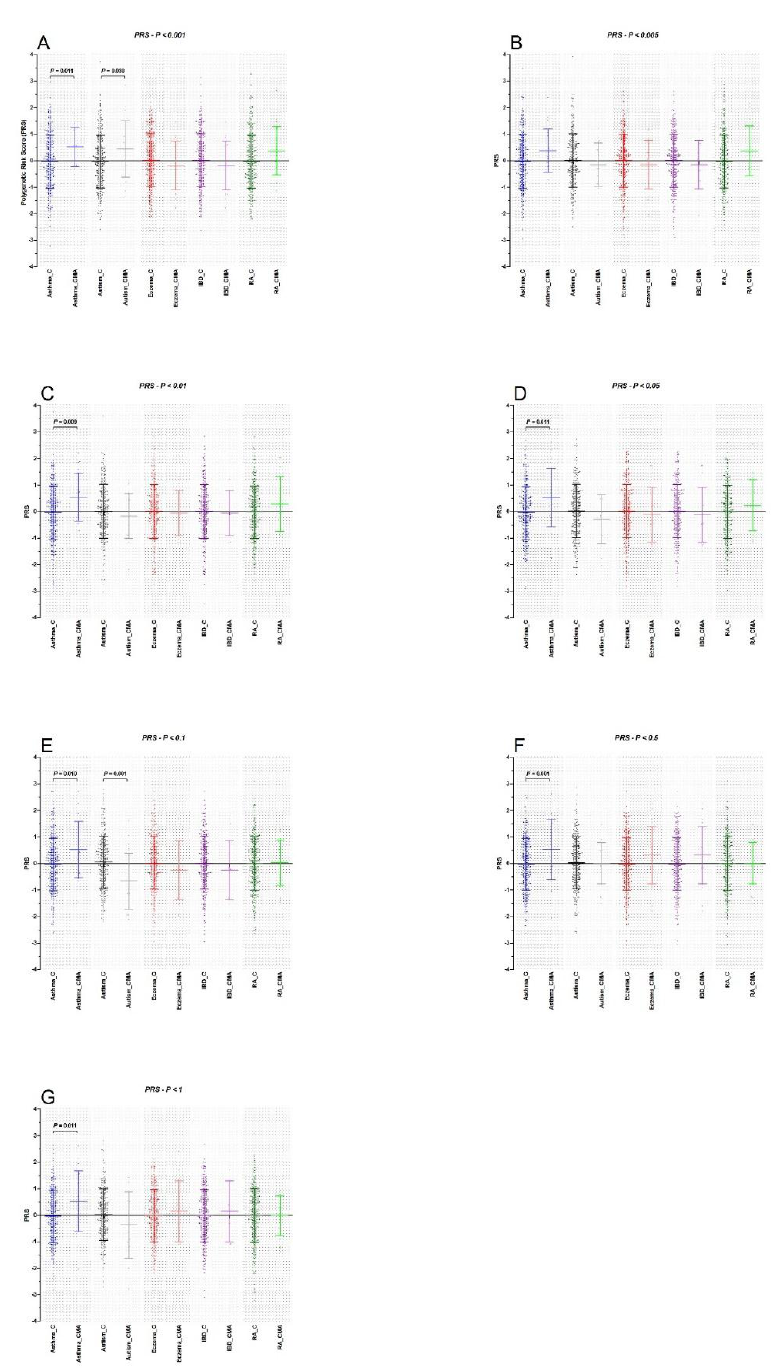
Figure 1. Polygenic risk scoring (weighted) for hypersensitive immune disorders asthma, autism spectrum disorder, atopic eczema, inflammatory bowel disease and allergic rhinitis (Prism 5.01, 2007). C: represents PRS in controls ( N = 307), CMA represent PRS in (former) cow’s milk allergic children ( N = 22). ( A ) PRS scoring with (GWAS) cutoff of P T < 0.001, ( B ) PRS scoring with (GWAS) cutoff of P T < 0.005, ( C ) PRS scoring with (GWAS) cutoff of P T < 0.01, ( D ) PRS scoring with (GWAS) cutoff of P T < 0.05, ( E ) PRS scoring with (GWAS) cutoff of P T < 0.1, ( F ) PRS scoring with (GWAS) cutoff of P T < 0.5 and ( G ) PRS scoring with (GWAS) cutoff of P T < 1. Parametric test ( t -test) was performed to test for differences in means of the PRS between former CMA patients and healthy controls. We assumed a P < 0.05 statistically significant.